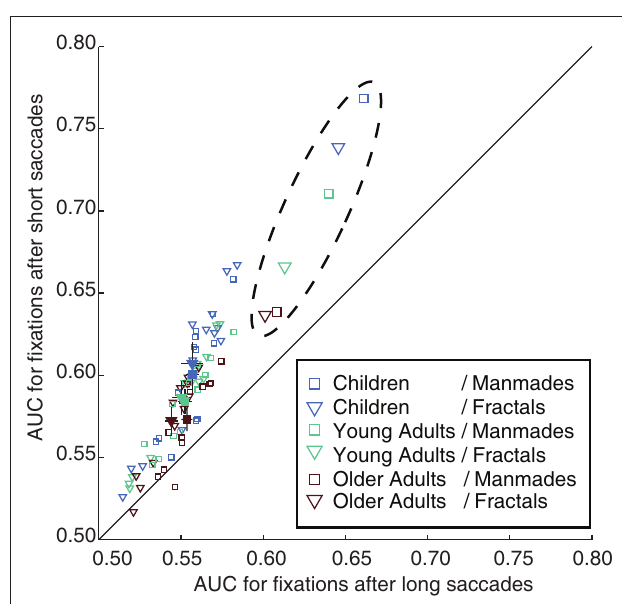
Figure 7 | Saccade size differences on feature-related viewing. After age-specific median splits on saccade size, AUC for each feature was computed for fractals and manmades once for fixations at the end of short saccades (ordinates) and once for fixations following longer saccades (abscissae). The markers in the dashed ellipse show the same analysis on IO saliency and reveal the same pattern. Empty symbols denote age, category, feature combinations, and filled symbols denote the averages over features together with 95% CIs. Accumulation of the values above the diagonal reveals that feature values were relatively higher at the end of shorter saccades, which holds for all age